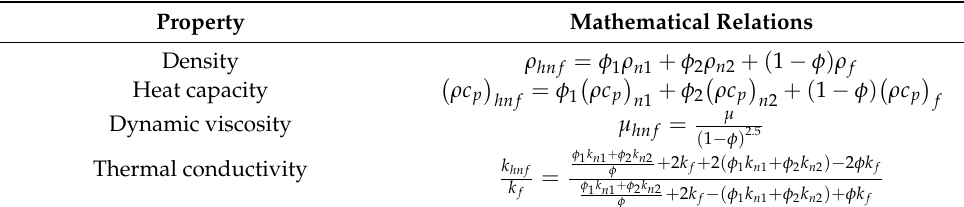
Table 2. Applied model for thermophysical properties of spherical hybrid nanoparticles